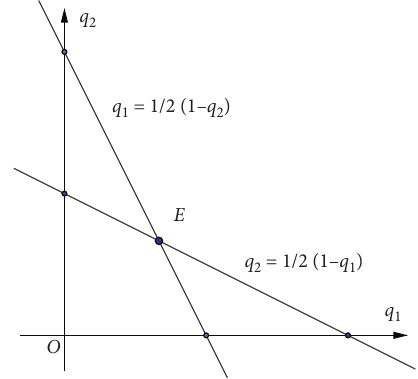
Figure 2: The response functions in the Cournot